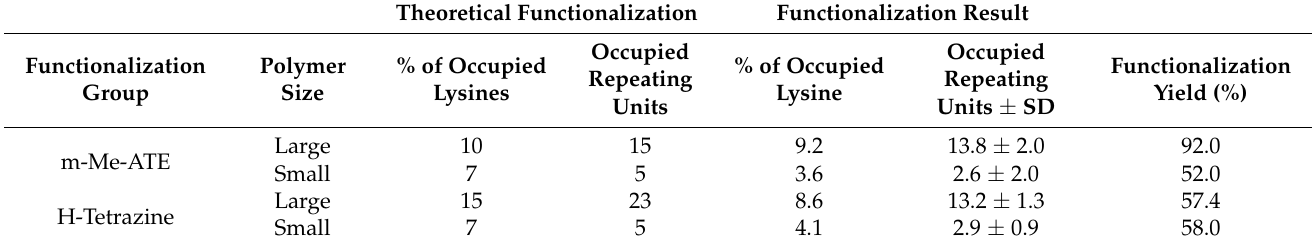
Table 1. Poly-L-lysine functionalization yield of large polymer (15–30 kDa, average 154 repeating units and 21 kDa, 143 repeating units) and small polymer (10 kDa, 68 repeating units). The table compares the theoretical (desired) versus the actual (obtained) functionalization in terms of the percentage and the absolute number of occupied lysine